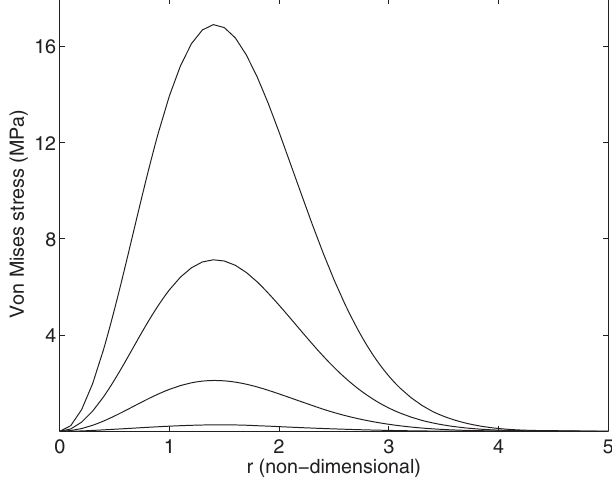
FIG. 8. Plot of the Von Mises stress versus the radius for the beam and material setup described in Tables I and II. In ascending order the curves drawn are for times of t ¼ 0 . 25 , 0.5, 0.75, 1,